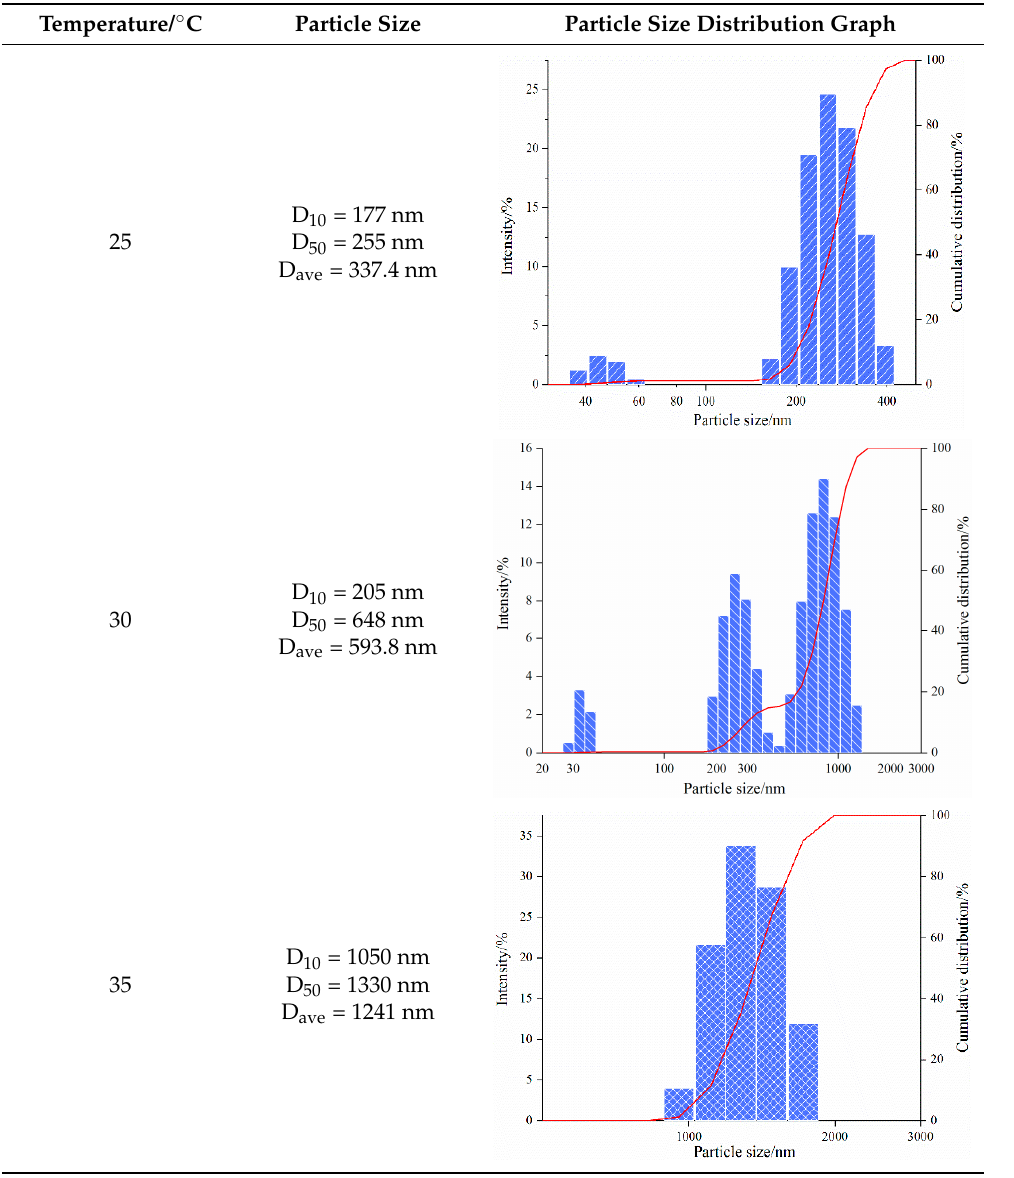
Table 4. Variation in the particle-size distribution of PNBAM aqueous solutions with temperature.